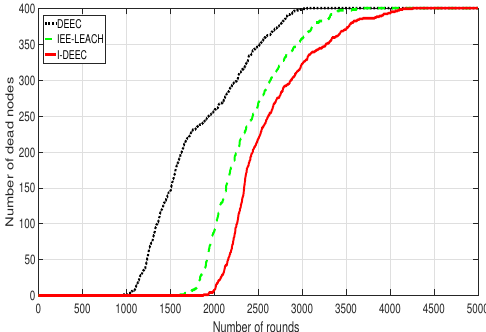
Figure 11. Comparison of changes in the number of dead nodes with time.